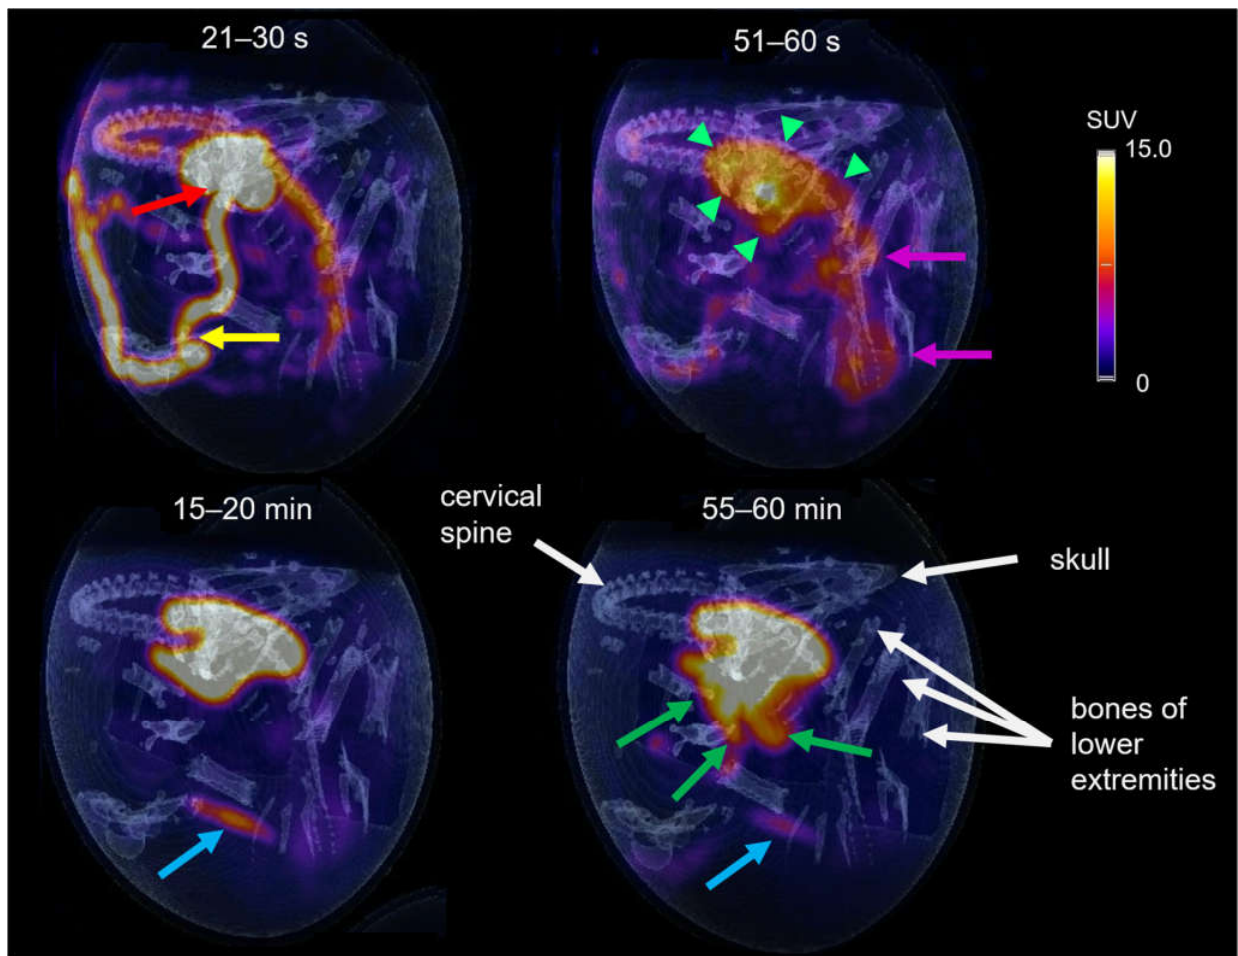
Figure 7. PET/CT of [ 68 Ga]Ga-TMoS-DAZA in an ostrich embryo at different time frames. At early time points the vitelline vein (yellow arrow) and the heart (red arrow) are visible, as well as early accumulation in the liver (short green arrows) and kidneys (pink arrows). After 15–20 min a weak activity accumulation in the cloaca (blue arrow) can be observed, while excretion into the duodenum (green arrows) is visible at 55–60 min. White arrows point to osseous structures.